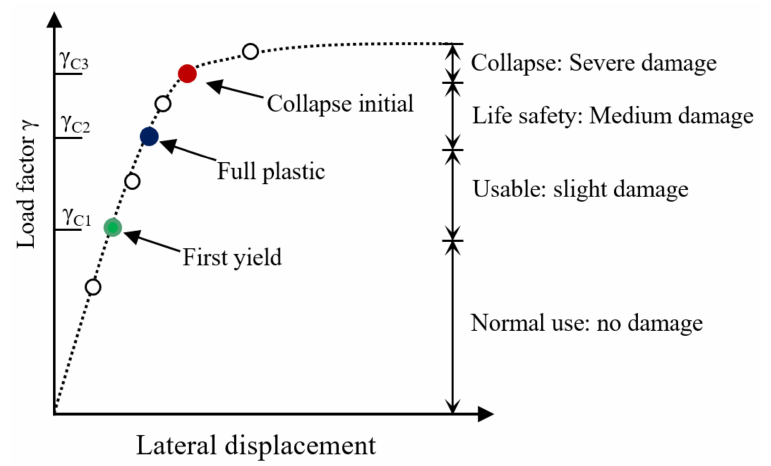
Figure 2. The relationship curve between the load factors and the lateral displacement at the top of the